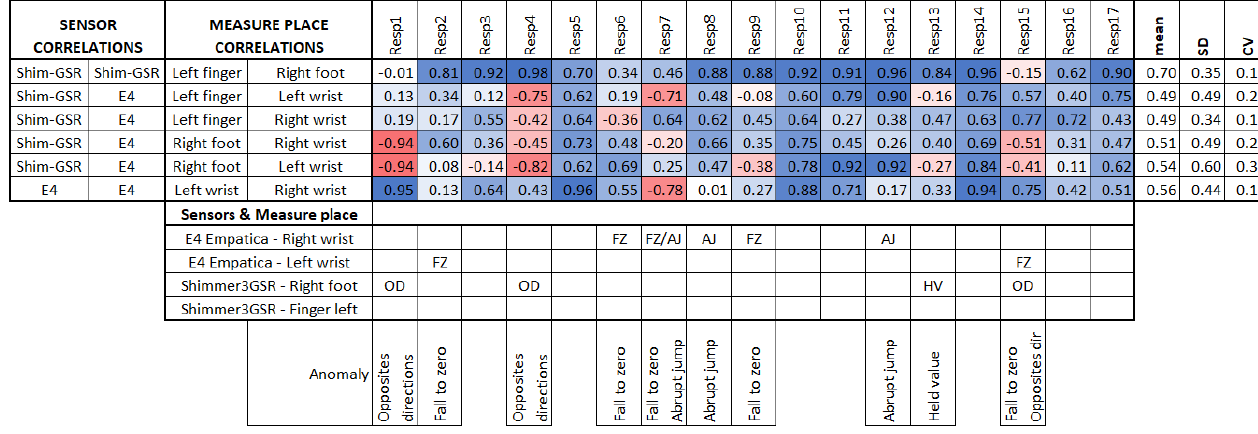
Figure 8. Correlation between signals in each respondent. In the bottom part, the anomalies detected relate to each re- spondent, measurement location, and sensor. OD, opposite directions; FZ, fall to zero; AJ, abrupt jump; HV, held value.